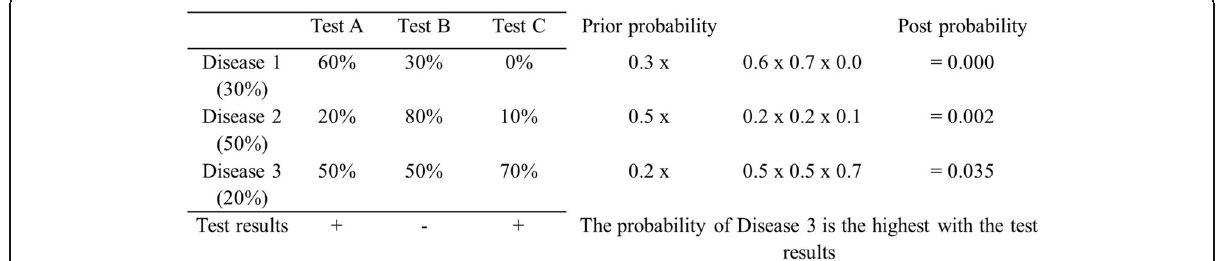
Fig. 2 The prior and post probability based on Bayes ’